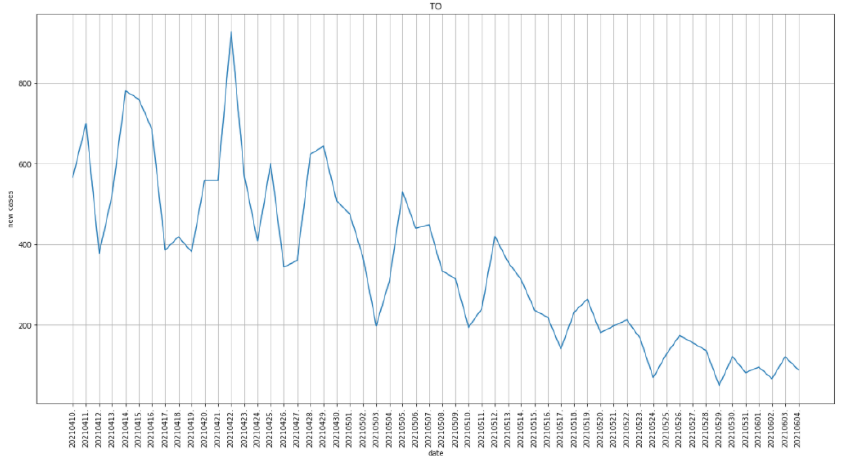
Figure 6. Daily new cases of COVID-19 in Provincia di Torino. Vertical axis: daily new cases, horizontal axis: date.